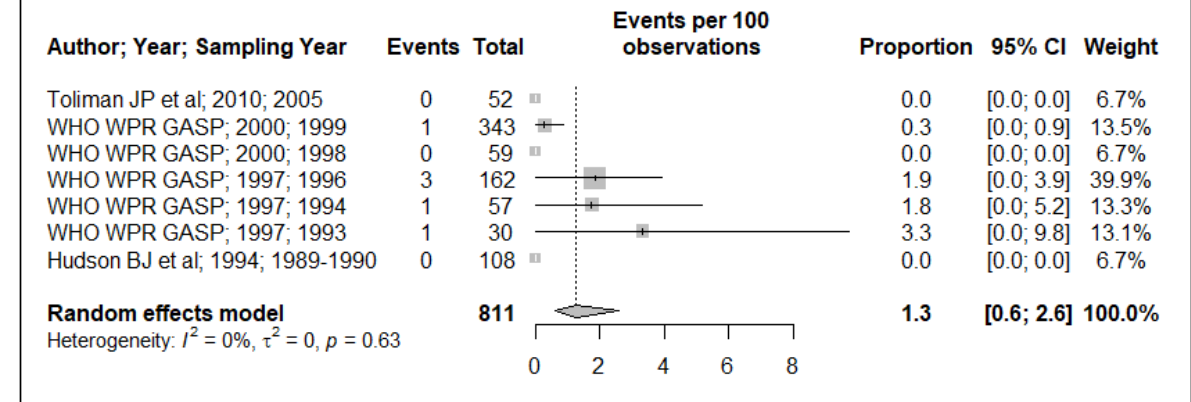
Figure 6. Spectinomycin resistance prevalence estimate.